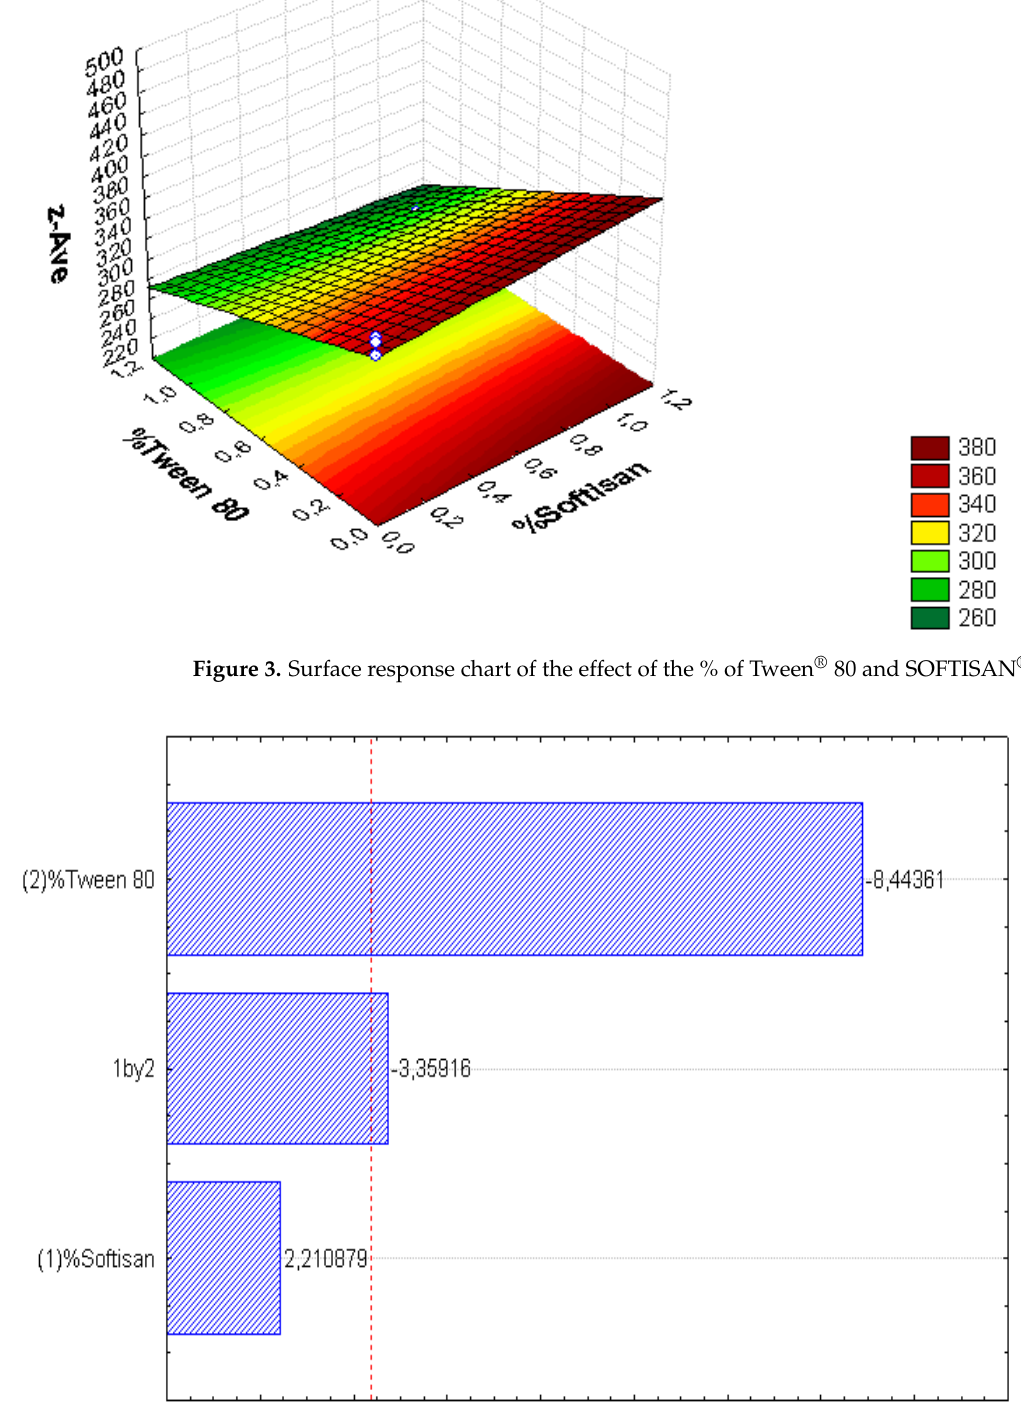
Figure 4. Pareto chart of the analyzed effects for z-Ave.